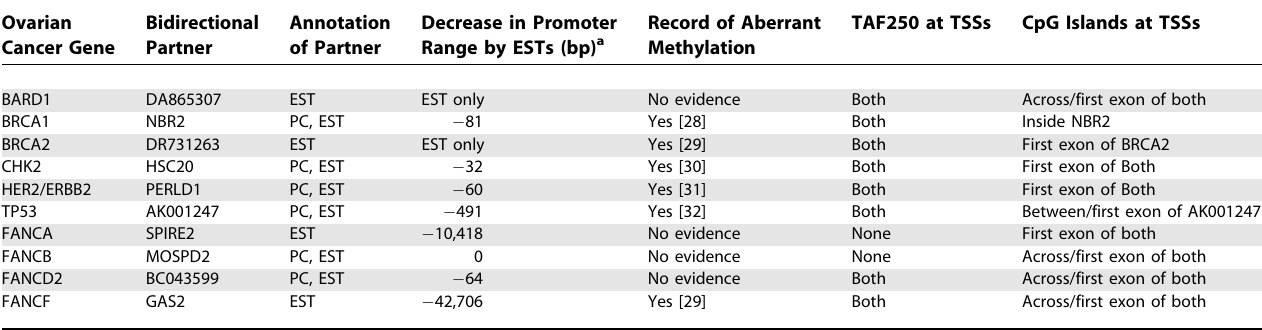
Table 1. Somatic Ovarian Cancer Genes Regulated by Bidirectional Promoters Ovarian Bidirectional Cancer Gene